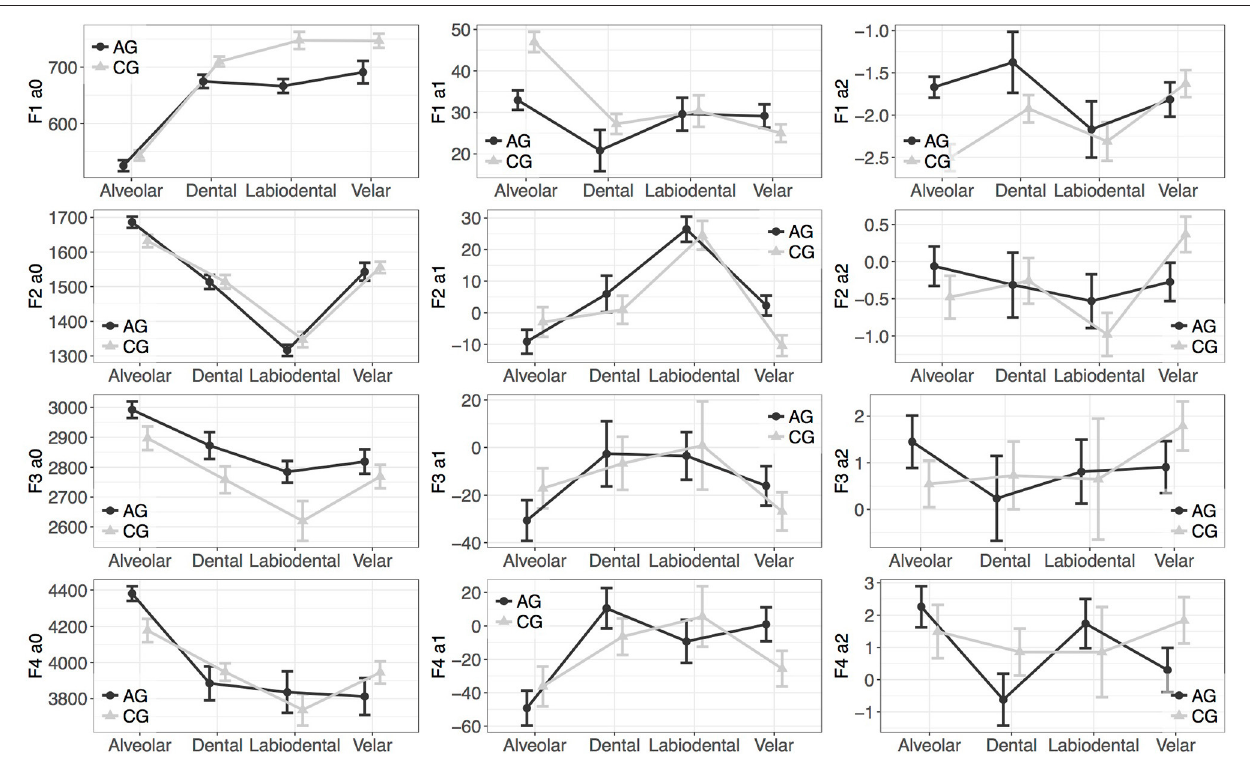
FIGURE 6 | Means and SD of the polynomial coefficients of the vowel formants of /a/, preceded by the unstressed voiced alveolar, dental, labiodental, and velar fricatives.